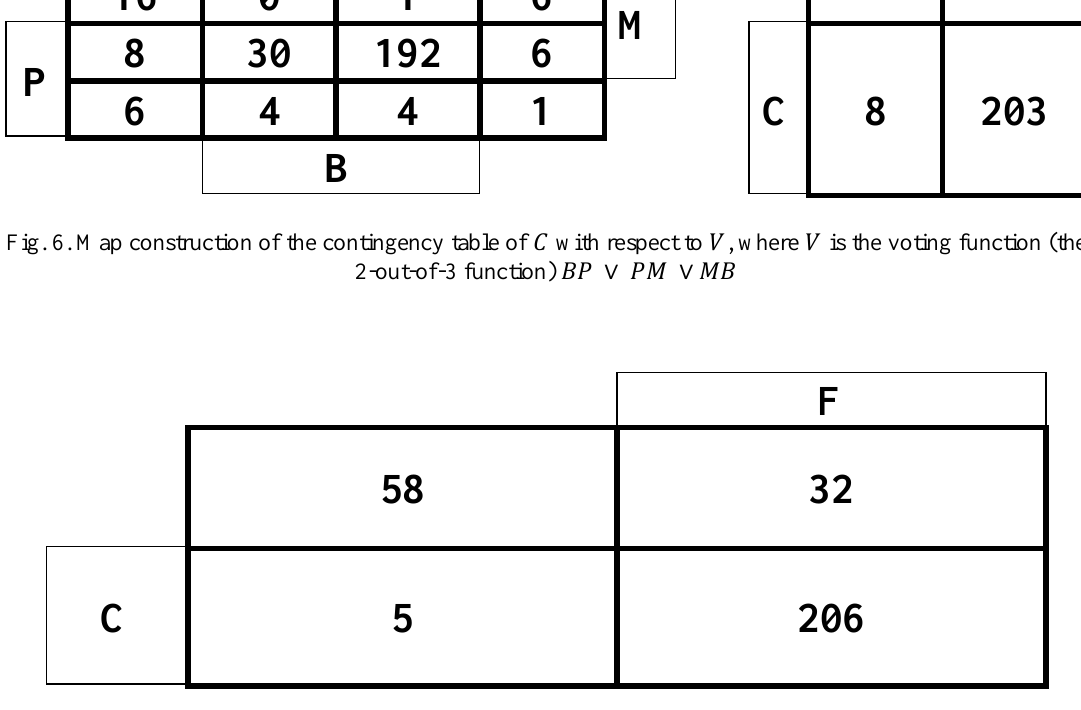
Fig. 7. The contingency table of 𝐶 with respect to 𝐹 , where 𝐹 is the overall real voting